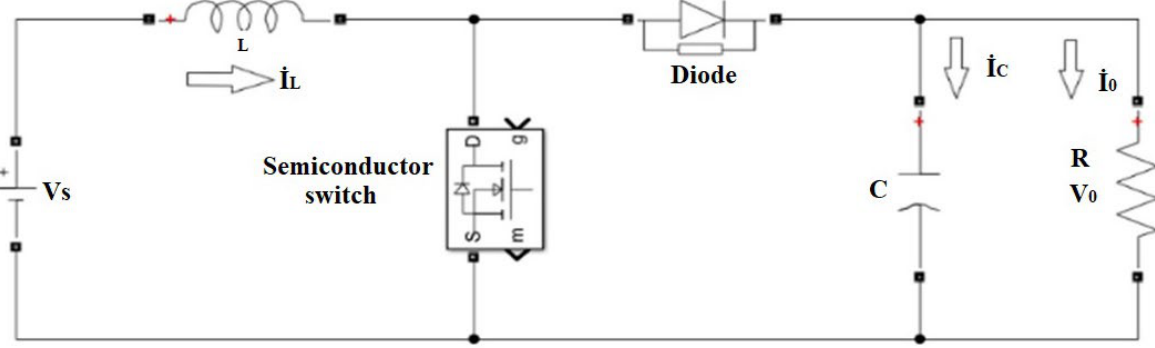
Figure 6. Overview of the structure of a two - stage grid - connected photovoltaic system. When using a boost converter to regulate a PV array, either an open or closed loop can be utilized. When operating at constant current and low irradiance, a photovoltaic array ’ s dynamic resistance is at its lowest. The stability and dynamic response are terrible. A single - loop PI voltage controller cannot close - loop control the array voltage because the